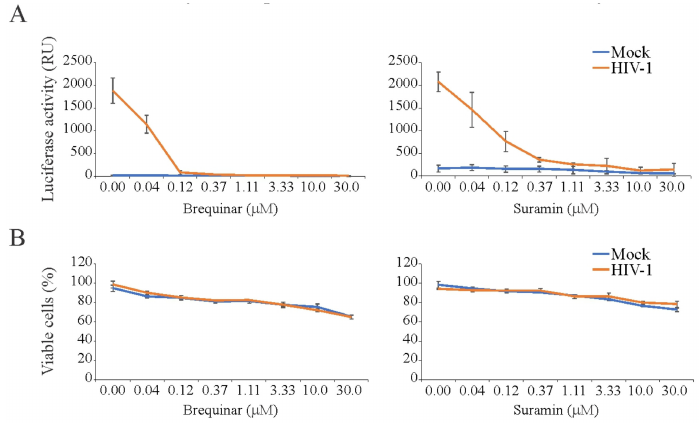
Figure 4. E ff ect of brequinar and suramin on human immunodeficiency (HIV-1)-mediated luciferase expression and the viability of mock- and virus-infected TZM-bl cells. ( A ) TZM-bl cells were treated with increasing concentrations of a compound and infected with mock or HIV-1 (300 ng / mL of HIV-1 p24). After 24 hpi, the medium was removed from the cells, the cells were lysed, and firefly luciferase activity was measured using the Luciferase Assay System (Mean ± SD; n = 3). ( B ) In a parallel experiment, Cell Tox Green reagent (CTxG) reagent was added to the cells and the fluorescence was measured. The percentage of viable cells was calculated. Mean ± standard deviation (SD); n = 3 (experimental